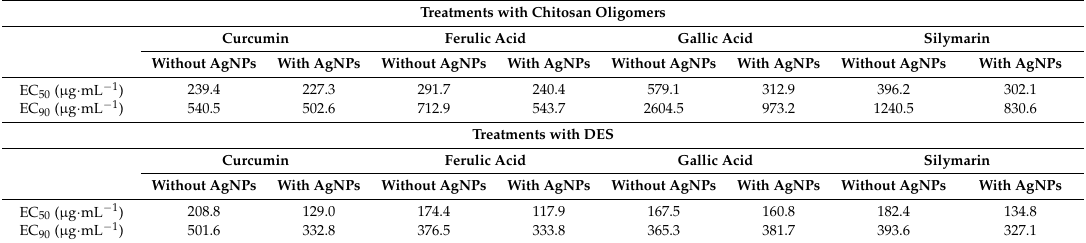
Table 3. Effective concentrations of the composites that inhibited mycelial growth by 50% and 90% (EC 50 and EC 90 , respectively).